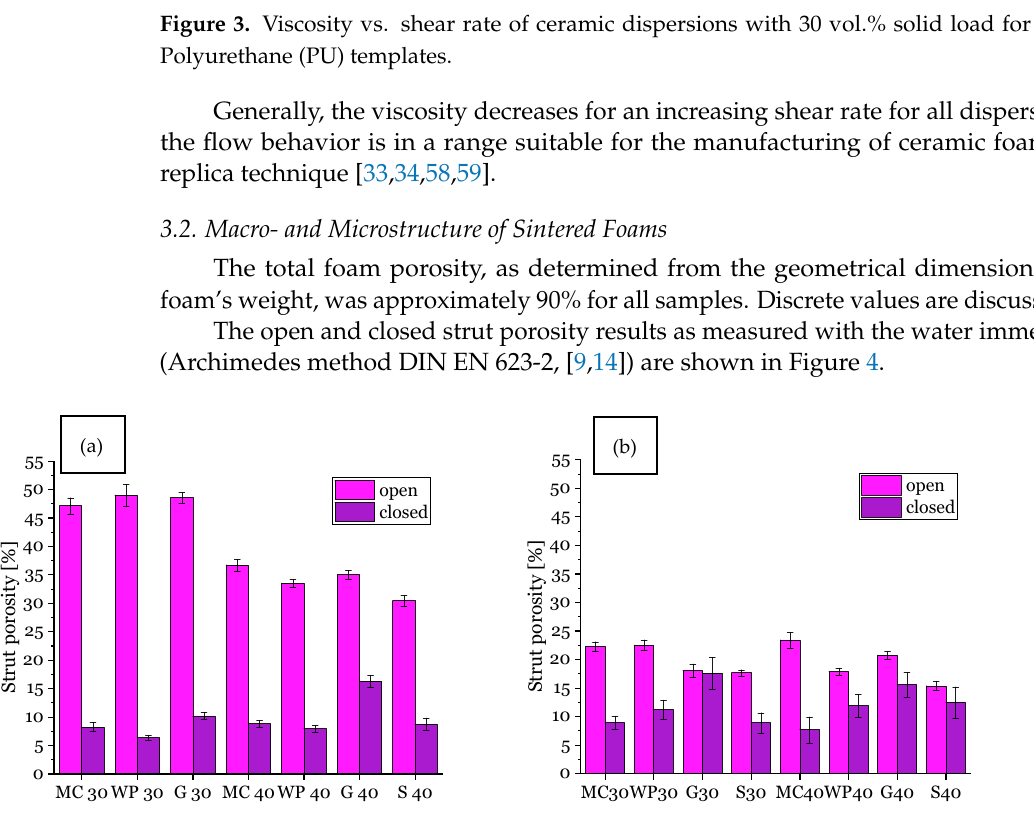
Figure 4. Open and closed strut porosity of samples with 30 vol% (30) and 40 vol% (40) solid load in ceramic dispersion, ( a ): with additional strut porosity from freeze-drying, ( b ): without additional strut pores/conventionally dried samples; MC = methylcellulose, WP = wallpaper paste, G = guar gum, S = Starch.